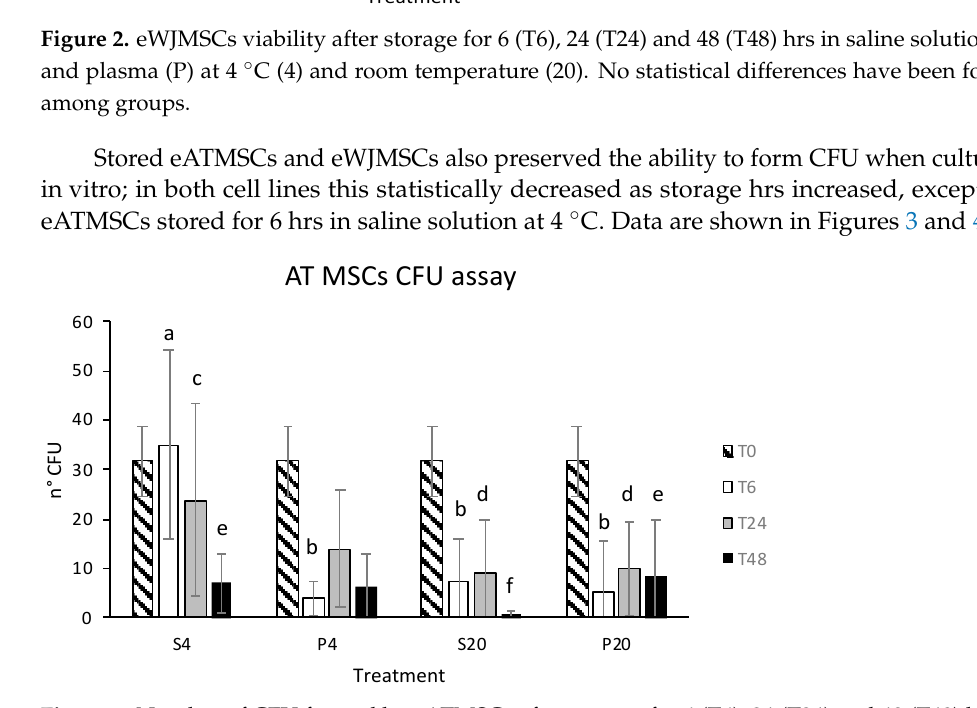
Figure 3. Number of CFU formed by eATMSCs after storage for 6 (T6), 24 (T24) and 48 (T48) hrs in saline solution (S) and plasma (P) at 4 °C (4) and room temperature (20): a vs. b; c vs. d; e vs. f: p < 0.05.